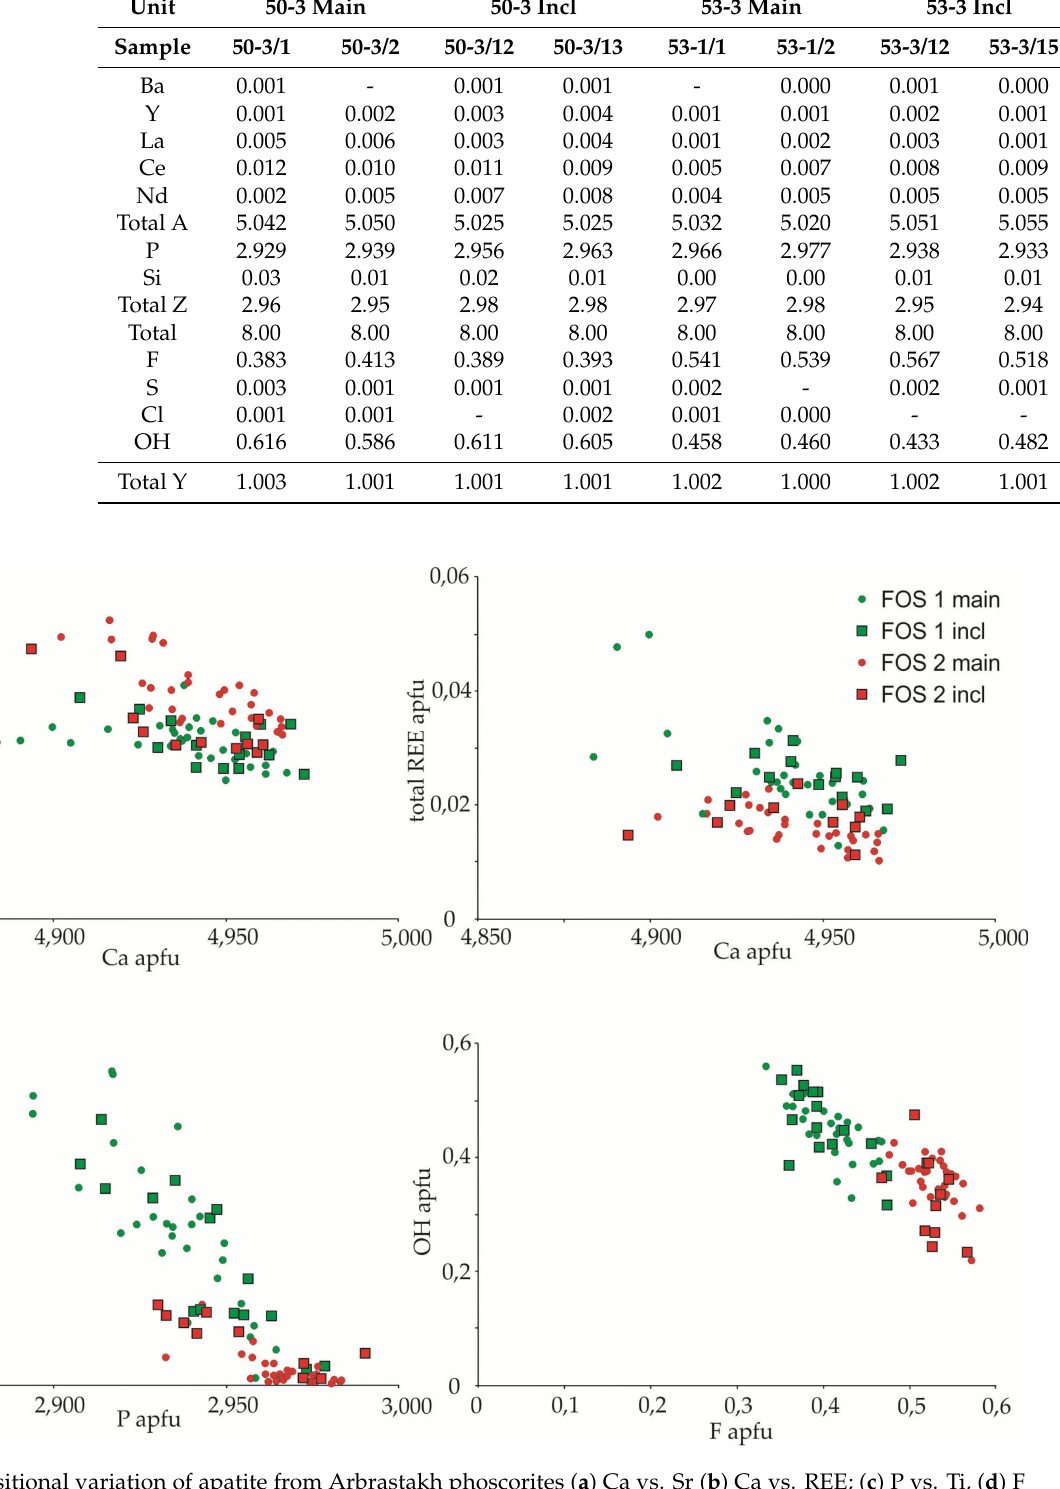
Figure 5. Compositional variation of apatite from Arbrastakh phoscorites ( a ) Ca vs. Sr ( b ) Ca vs. REE; ( c ) P vs. Ti, ( d ) F vs.